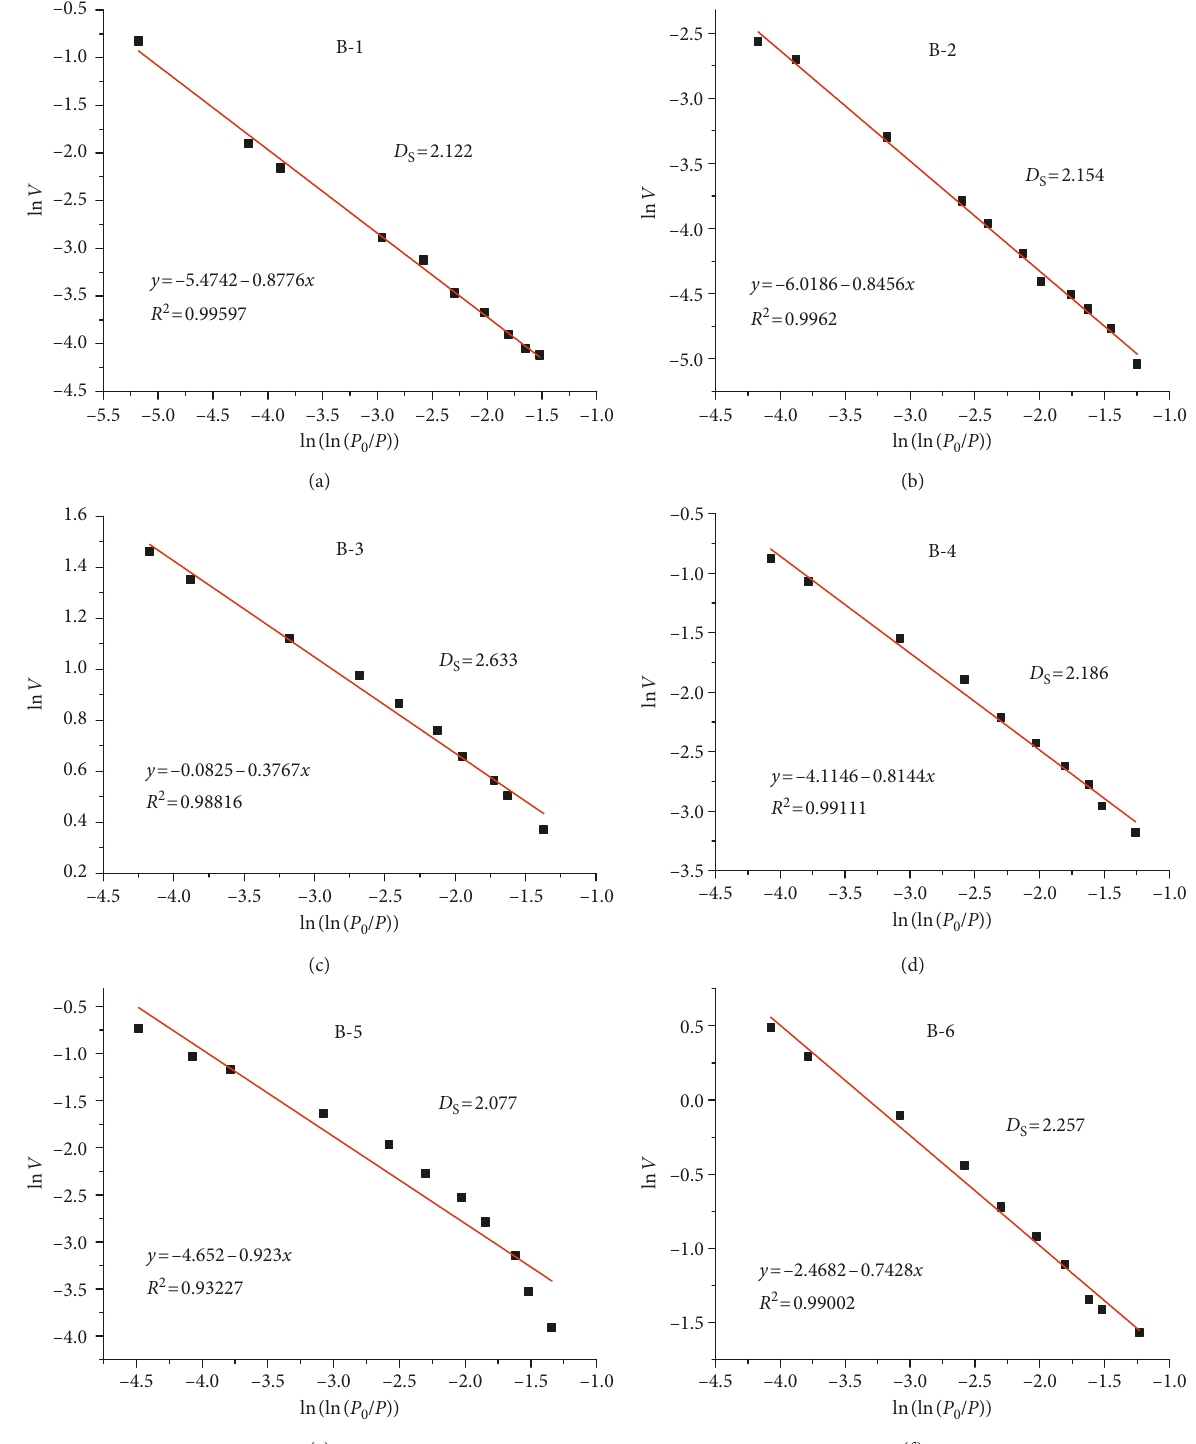
Figure 10: Calculation of pore surface fractal dimension for the B-1 to B-6 coal